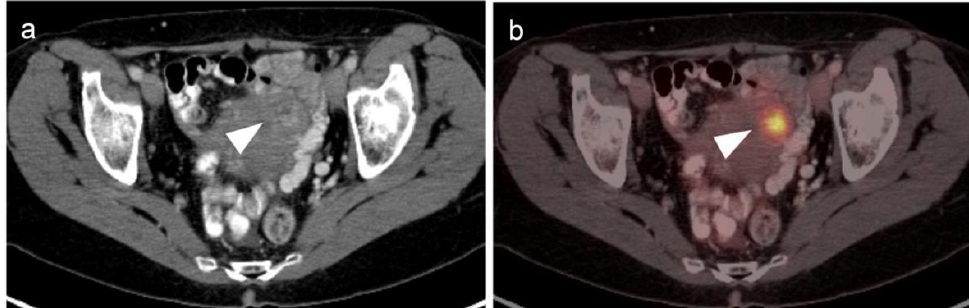
Figure 2. Benign leiomyoma (uterine fibroid). ( a ) Axial contrast-enhanced CT of the pelvis shows vague enhancement of a uterine nodule (white arrowhead); ( b ) Axial FDG PET-CT images of the pelvis at the same level shows a hypermetabolic uterine nodule, which was felt by additional imaging and stability over time to be a benign uterine leiomyoma. Metabolic activity within uterine leiomyomas can be extremely variable. Some are hypermetabolic for unknown reasons, as is shown here (white arrowhead).